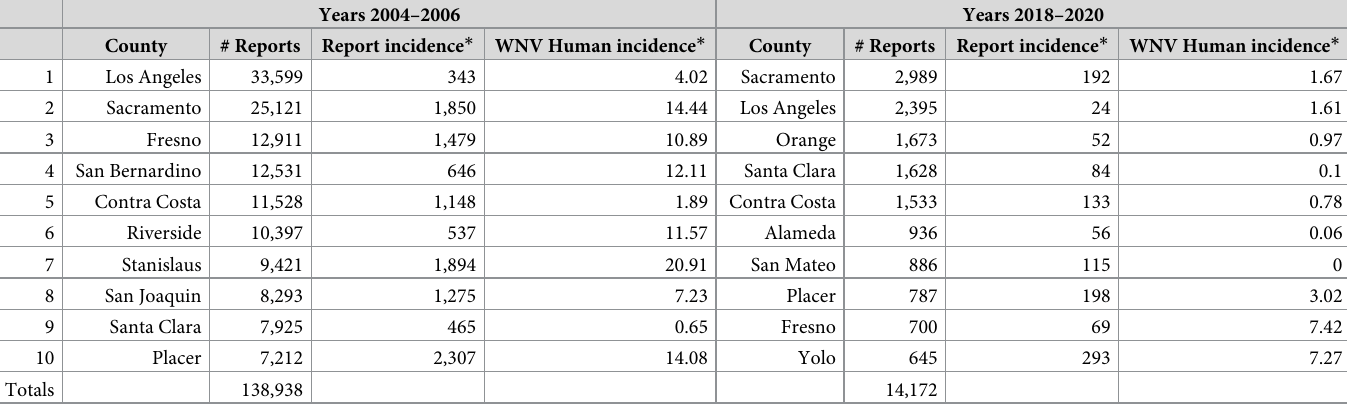
Table 1. Top ten California counties in early and recent time periods: Total number of reports, report incidence, and corresponding WNV human incidence for each three-year